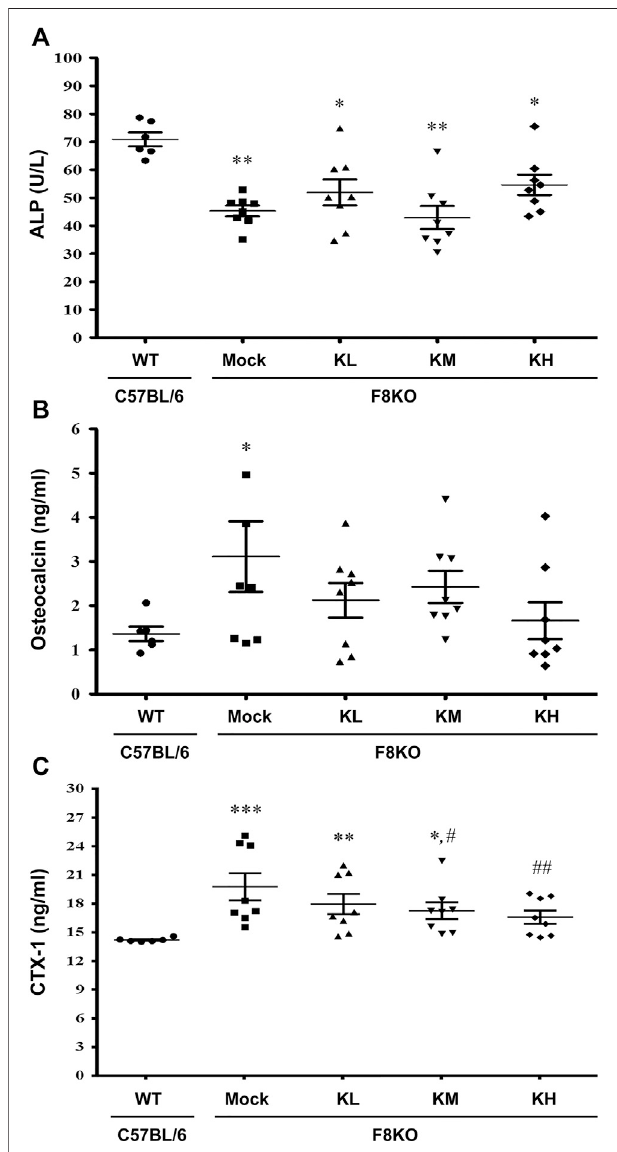
FIGURE 5 | Effects of KP treatment on serum bone turnover markers. F8KO mice at 20 weeks of age were orally administered different dosages of KPs for 8 weeks ( n = 8). At the end of treatment, mouse blood was collected for bone turnover marker detection. The quantitative data revealed the levels of (A) alkaline phosphatase (ALP), (B) osteocalcin (OC), and (C) C-telopeptide of type I collagen (CTX1) for the KP-treatment groups with differentdosages.* p < 0.05,** p < 0.01, *** p < 0.001 vs. WTgroup; # p < 0.05, ## p < 0.01 vs. mock